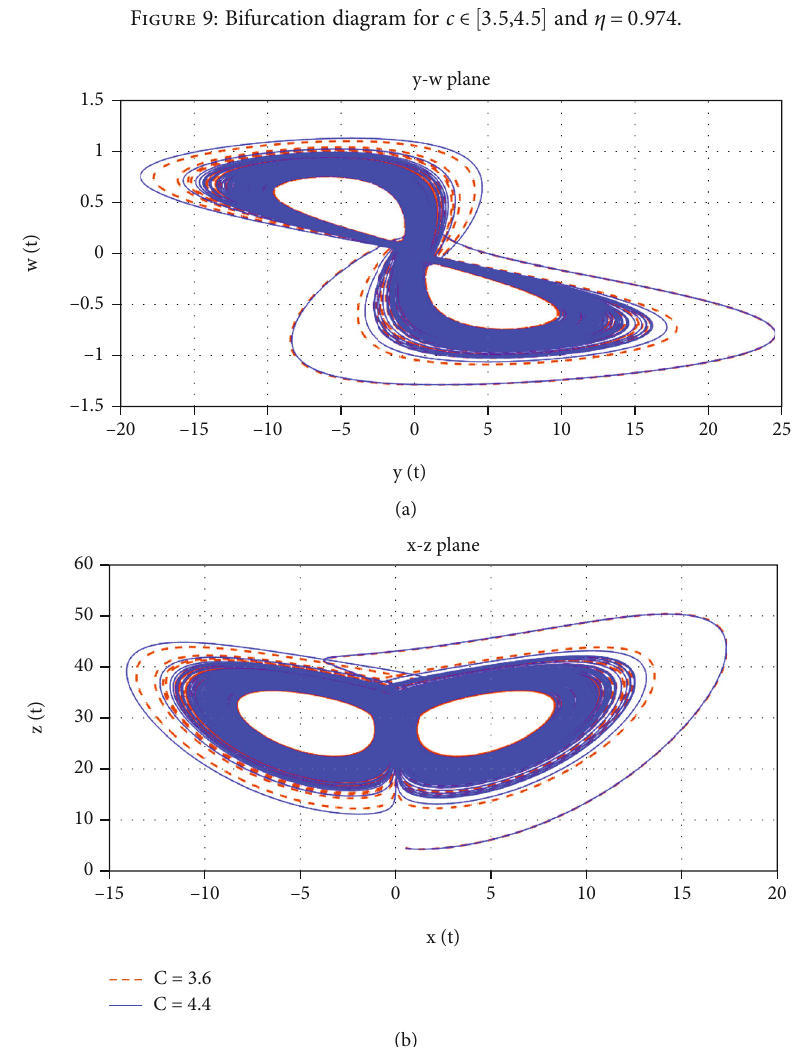
Figure 10: Attractors of the LS system (5) for c = 3 : 6 and 4.4 projected on the planes: (a) y - w , (b) x - z , and (c) x - w